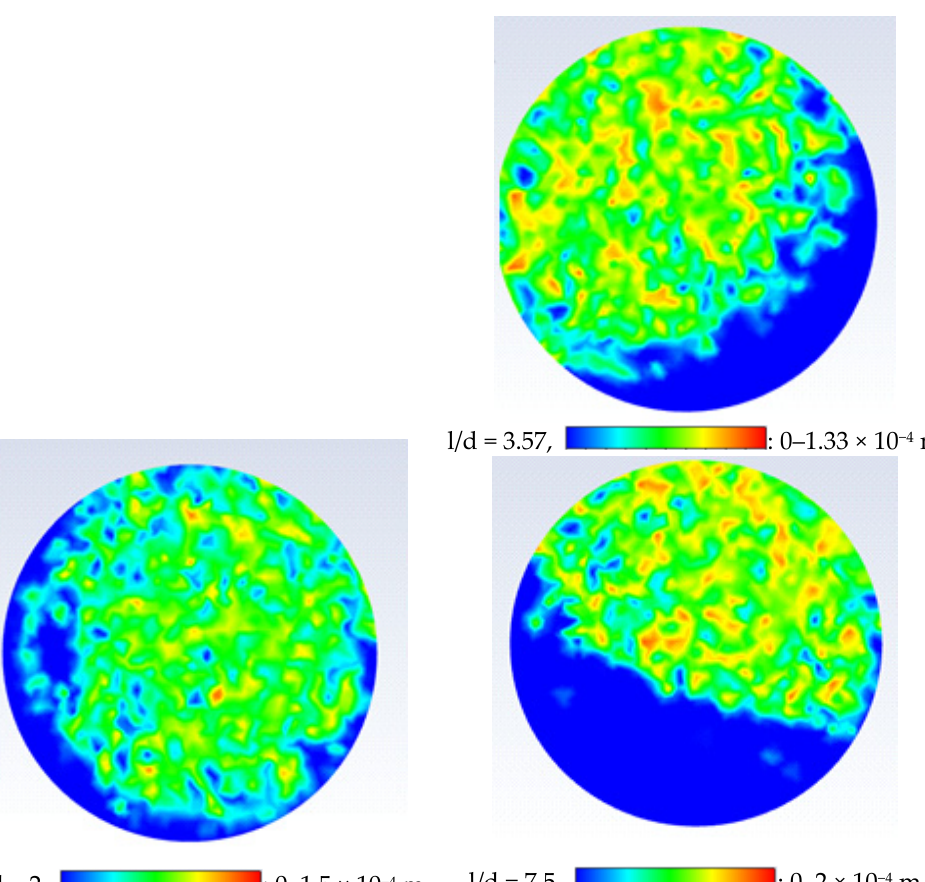
Figure 13. The contours of bubble distribution at the outlet section of the diffuser. (Water flow rate = 8.21 L/min, air flow rate = 0.1 L/min).